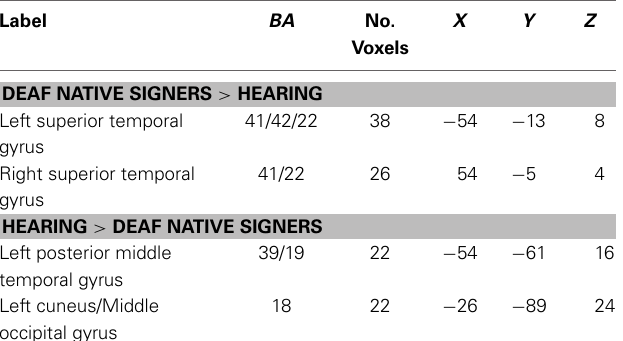
Table 5 | Regions in which functional connectivity with LIFG pars triangularis (BA 45) differed between hearing and deaf native signers, p < 0 . 05